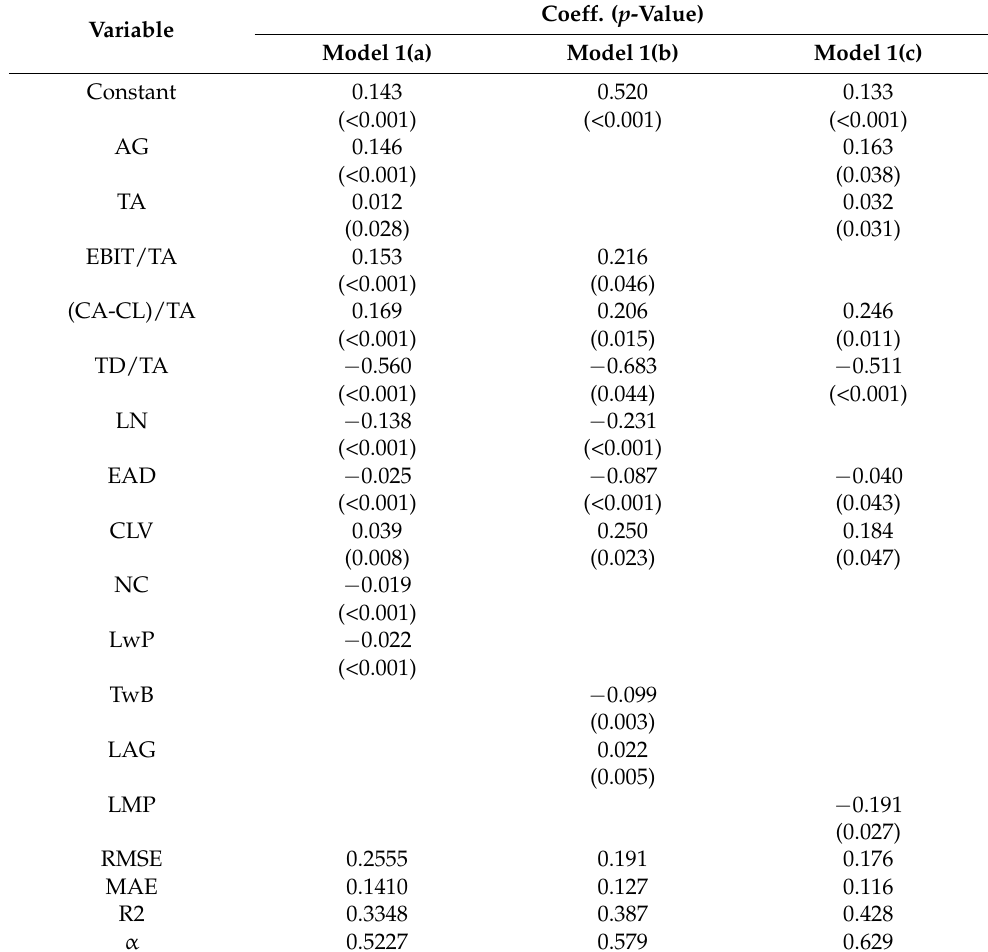
Table 3 below outlines the designed models based on firm and loan characteristics. Table 3. Models based on firm and loan